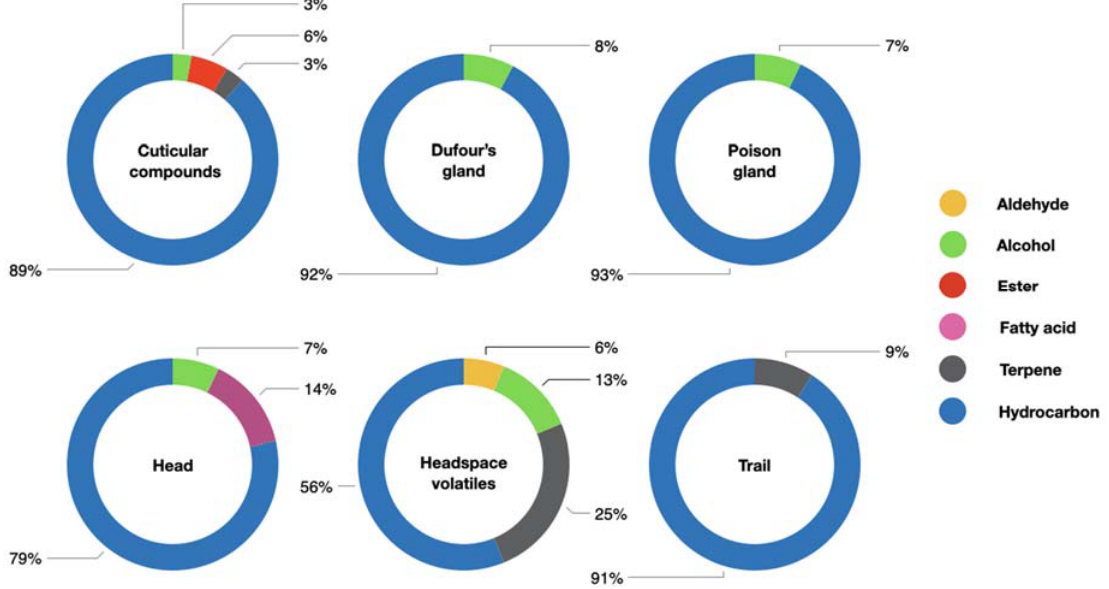
Figure 1. Composition of compounds isolated from the green tree ant, Oecophylla smaragdina . The dominant components were hydrocarbons, with other compounds being less abundant.